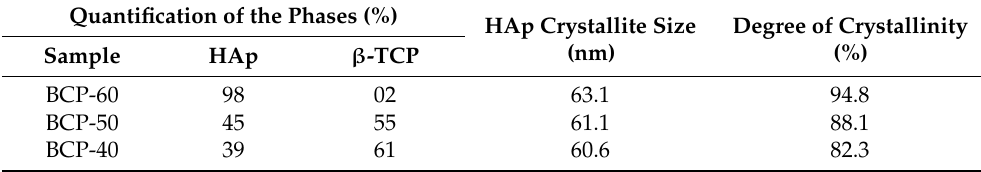
Table 1. Quantification of phases, crystallite size, and degree of crystallinity of the samples. Quantification of the Phases